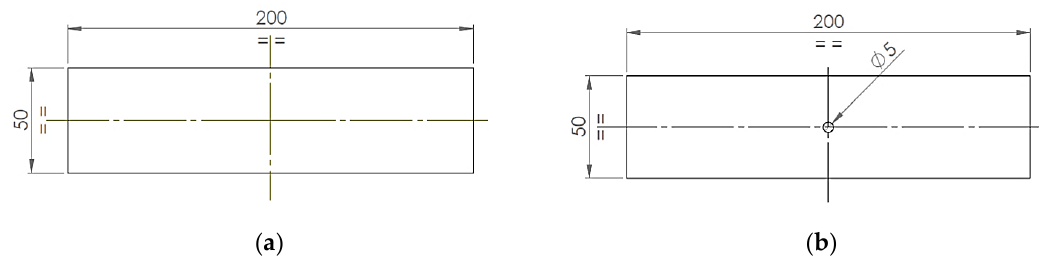
Figure 3. Dimensions and geometry of ( a ) four-point bending test samples without a hole and ( b ) with a hole.